Question: Condense the content of this figure into a single sentence.
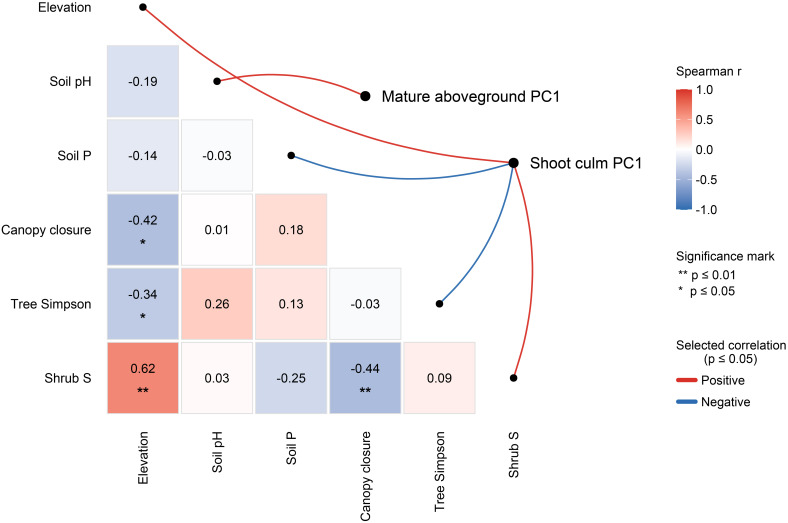
Answer: Spearman’s rank correlation screening of environmental and community predictors for PC1 scores. Red and blue arrows indicate positive and negative selected correlations, respectively. ** and * indicate p ≤ 0.01 and p ≤ 0.05.